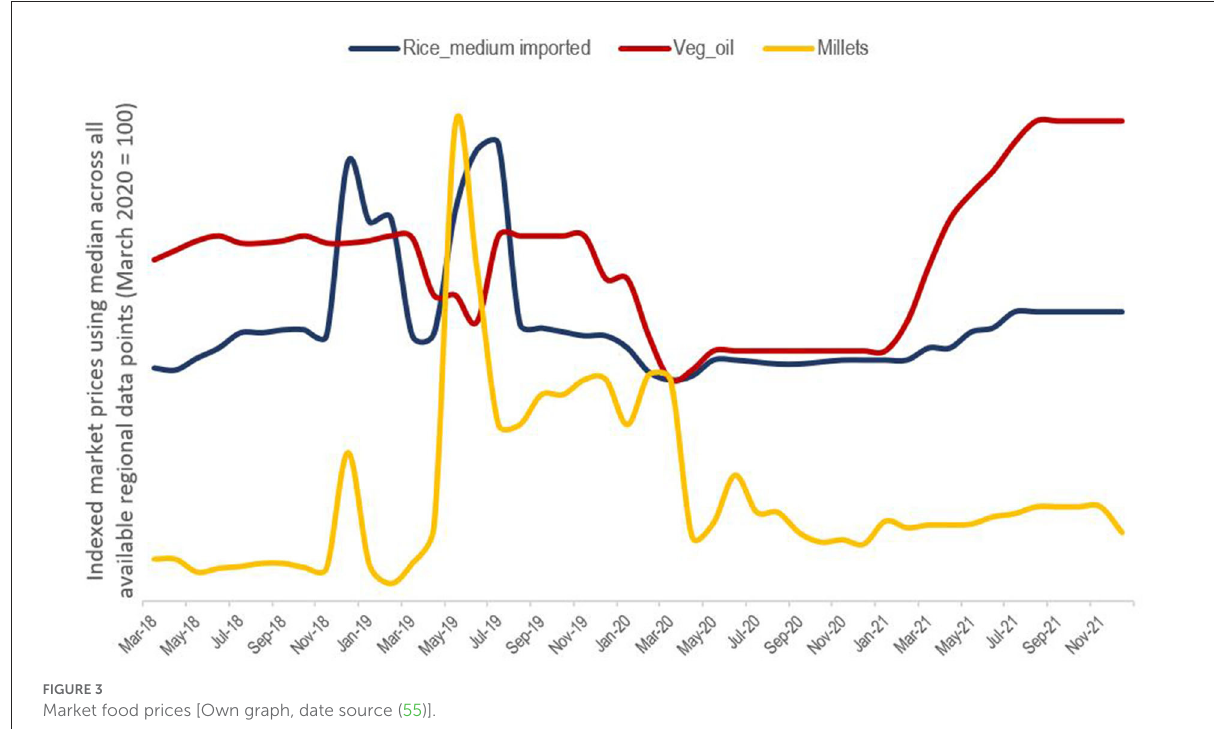
FIGURE3 Market food prices [Own graph, date source